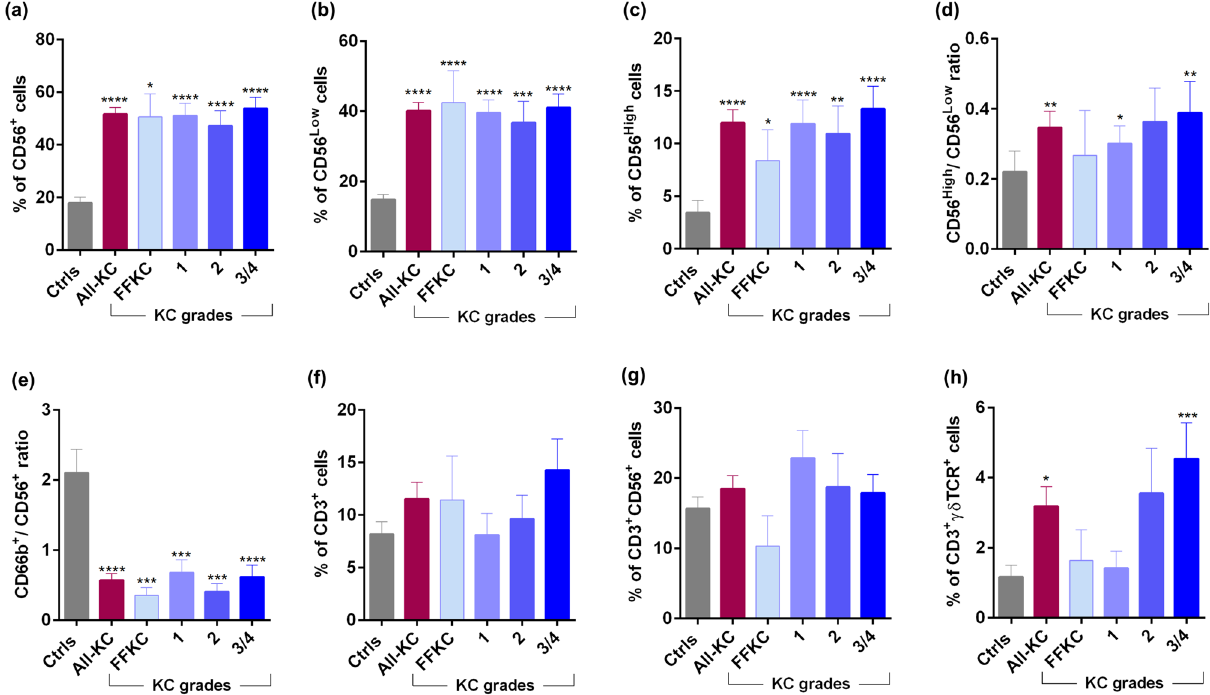
Figure 2. Ocular surface natural killer cells subsets and T cell subsets proportions in KC patients: The graphs indicate the percentage of CD45 + CD56 Total (Total Natural Killer—NK) cells ( a ), CD45 + CD56 Low —cytotoxic NK cells ( b ) and CD45 + CD56 High —cytokine producing low cytotoxic NK cells ( c ) within the leukocyte population in ocular surface wash samples of eyes with different grades of KC. The graph in panel ( d ) represent the ratio of cytotoxic NK cells to cytokine producing NK cells—CD56 High /CD56 Low and the graph in panel ( e ) represent the ratio of neutrophils to NK cells within the leukocyte population in ocular surface wash samples of eyes with different grades of KC. The graphs indicate the percentage of CD45 + CD3 + —Pan-T cells ( f ), CD45 + CD3 + CD56 + (Natural Killer T) cells ( g ) and CD45 + CD3 + γδTCR + (gamma delta) T cells ( h ) within the leukocyte population in ocular surface wash samples of eyes with different grades of KC. Ctrls—Controls; FFKC—Forme fruste keratoconus; All-KC—all the grades of keratoconus combined; SEM—standard error of the mean; Controls (23 eyes), All-KC (51 eyes), FFKC (6 eyes), grade 1 KC (14 eyes), grade 2 KC (8 eyes), grade 3 or 4 (23 eyes); Bar graphs represent Mean ± SEM; *P < 0.05, **P < 0.01,***P < 0.001, ****P < 0.0001, Mann–Whitney Kmean (Table 2). Further, a negative correlation was observed between gamma delta T cells proportions and pachymetry indices such as central corneal thickness and thinnest corneal thickness (Table 2). A positive corre- lation between pan-T cell proportion and Kmean, and a negative correlation between pan-T cell proportion and thinnest corneal thickness was also observed (Table 2). Interestingly, a positive association between activated neutrophil proportion and central corneal thickness and thinnest corneal thickness was noted (Table 2). The lev- els of IL-13, IL-17A, TNFα, Eotaxin and sP-selectin exhibited a positive association with one or more of the four keratometry indices such as K1, K2, Kmean and Kmax (Table 3). lL-12p70 and TGFβ1 levels were also positively related (near statistical significance) with K2 and Kmax (Table 3). On the contrary, the levels of sTNFRI, NGAL and EPO was observed to have a negative relationship with one or more of the keratometry indices (Table 3). Interestingly, a positive association was observed between the levels of IL-10 and keratometry indices, despite a negative association with pachymetry indices (Table 3). No significant difference in the ocular surface immune cell subset proportions and tear fluid soluble factor levels was observed between FFKC and contralateral KC eyes of different grades (Supplementary Tables 1 and Table 2). Since, allergy is strongly associated with KC, the influence of mild ocular allergy, history of systemic allergy and eye rubbing on the immune cell profile and soluble factor profile were also investigated. KC subjects with ongoing severe ocular or systemic allergy were excluded from the study. Hence, the subjects with mild ocular allergy included in the study are those who presented with KC along with mild or inactive conjunctival papillae and without any signs of congestion or redness. Immune cell subset proportions, particularly those that were significantly altered in KC compared to controls, were not observed to be significantly different between KC patients with and without history of systemic allergic disease (Supplementary Table 3), with and without mild ocular allergy (Supplementary Table 4) and, with and without history of eye rubbing (Supplementary Table 5). Significantly higher tear fluid levels of IL-1α, IL-9, IL-10, IL-13, TNFα, sVCAM, sTNFRII and IgE were observed in KC subjects with history of systemic allergy compared to those without (Supplementary Table 6). Significantly higher levels of cytokines (IL-2, IL-12/23p40, IL-12p70, IL-13, IL-17A, IFNα), chemokines (MIG/CXCL9; ITAC/ CXCL11), growth factors (TGFβ1, EPO, VEGF) and enzyme (MPO and angiogenin); and a significant reduction in NGAL was also observed in KC subjects with a history of eye rubbing (Supplementary Table 7). A similarly